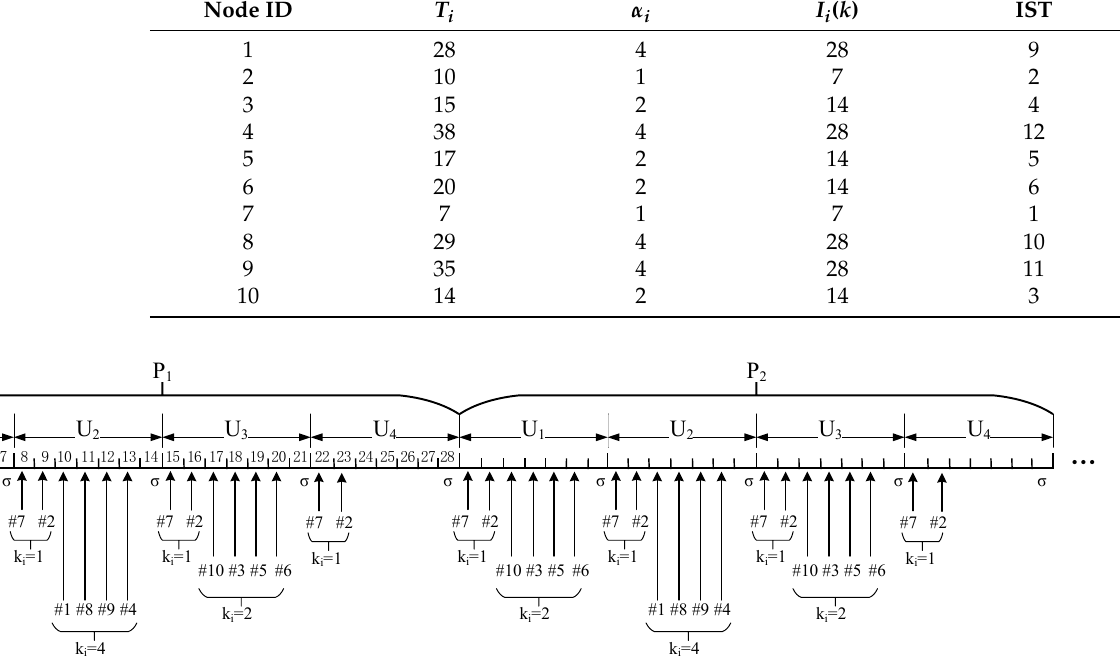
Figure 3. Illustration of the time slot allocation.